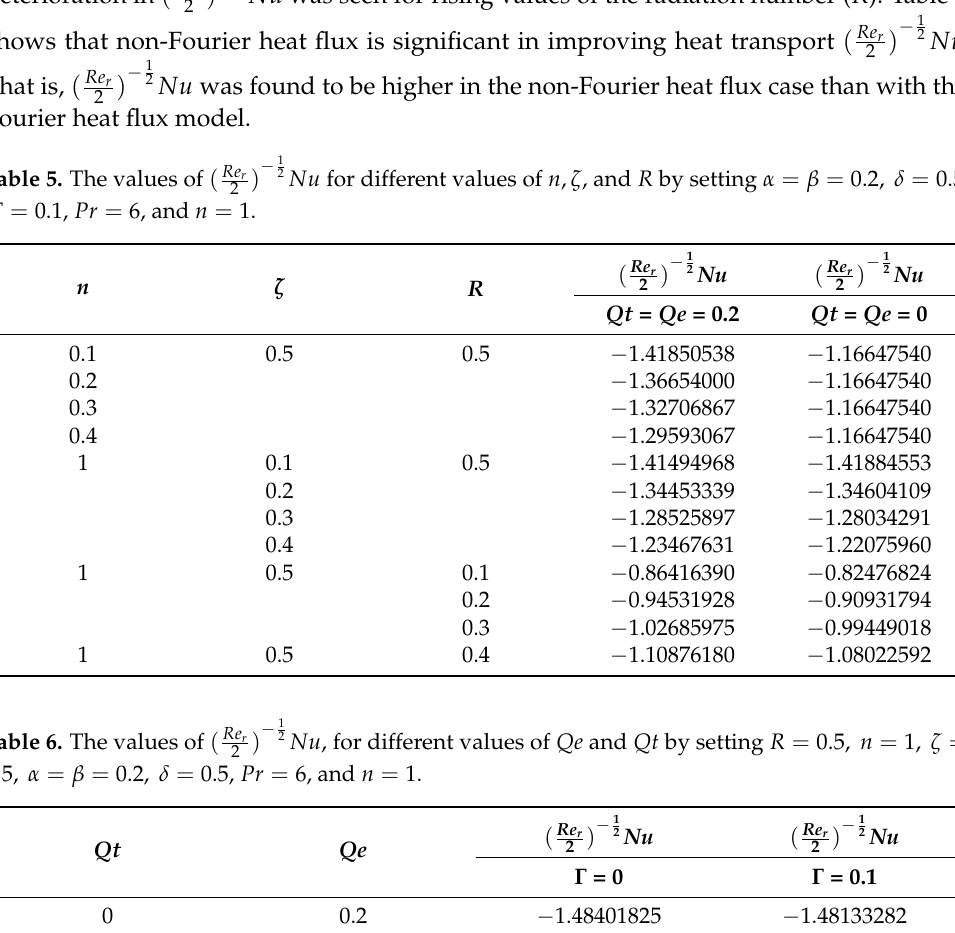
− 1 ) 2 Nu for different values of n , ζ , and R by setting α = β = 0.2, δ = 0.5, 2